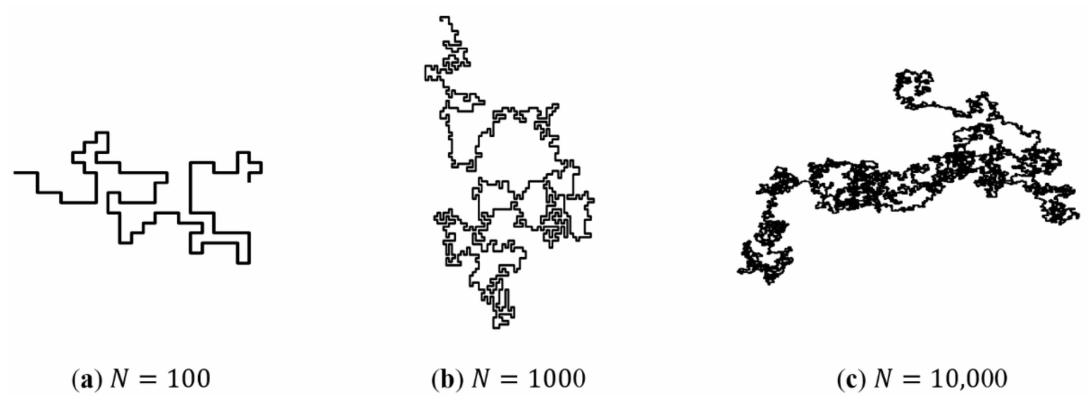
Figure 2. The SAW path generated by the computer program. As the number of steps N increases, the configuration of the path is similar to the real polymer